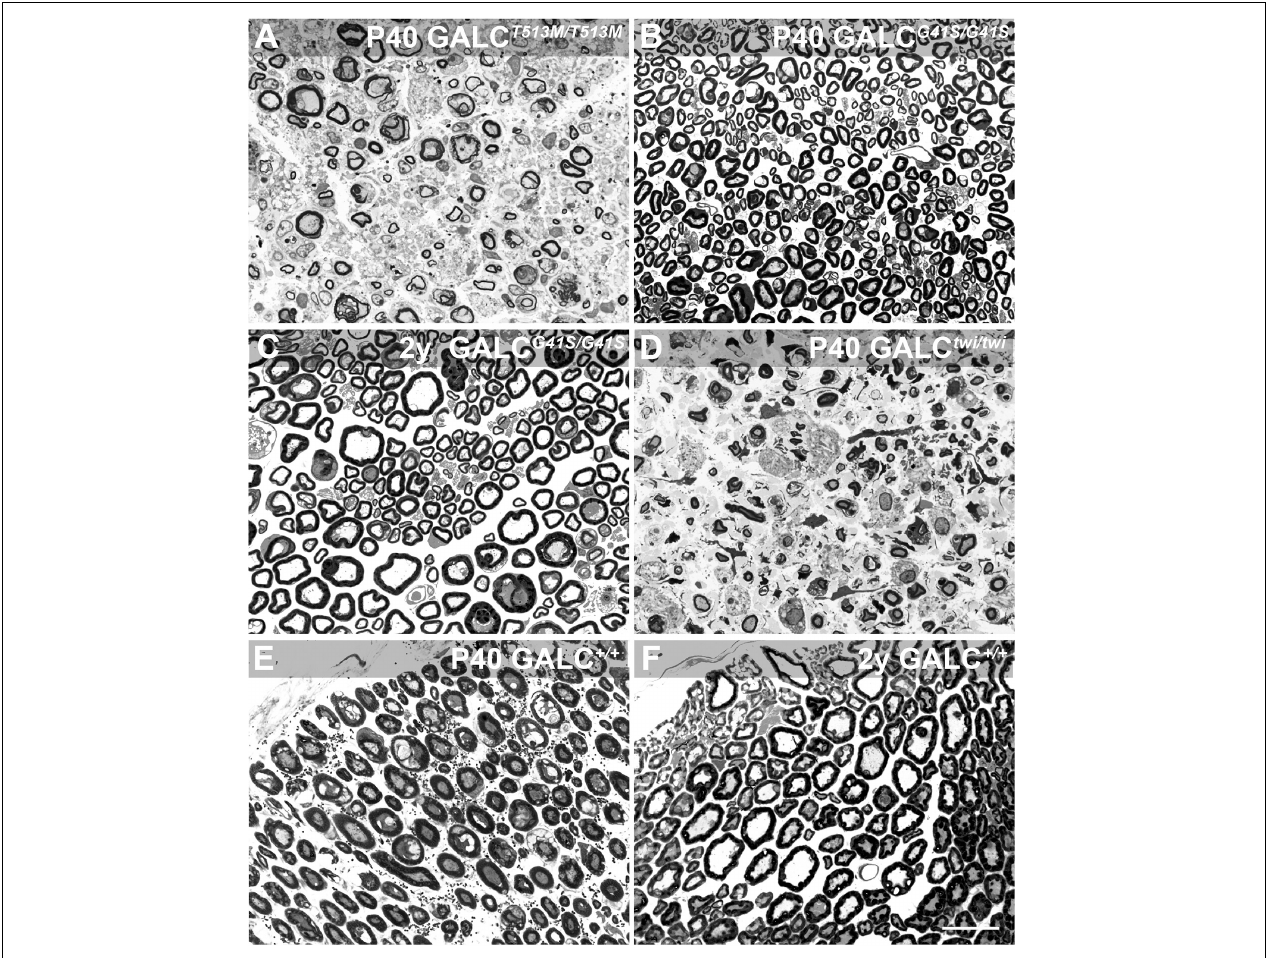
FIGURE 8 | GALC T 513 M / T 513 M but not GALC G 41 S / G 41 S mice exhibit signs of peripheral demyelination. Toluidine blue staining on plastic cross sections of sciatic nerves showed pronounced demyelination and edema in nerves from P40 GALC T 513 M / T 513 M mice (A) , comparable to damage observed in nerves from age matched TWI mice (D) . In contrast, no significant damage to myelin was detected in nerves from either P40 (B) or 2 y-old (C) GALC G 41 S / G 41 S mice. (E,F) cross sections of P40 and 2y WT sciatic nerves. Bar = 20 µ